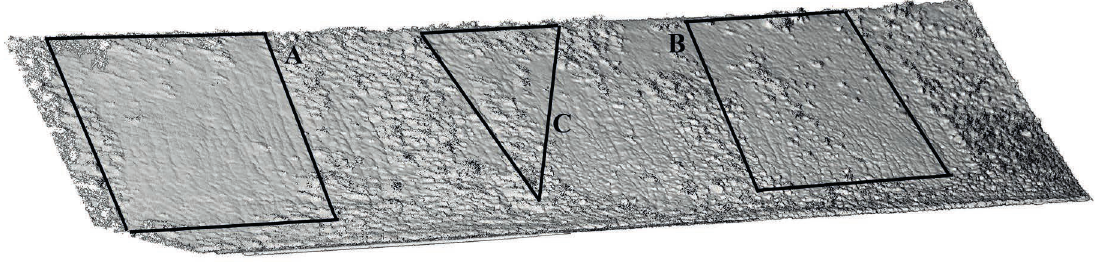
Fig. 3 Fragments of the experimental plot selected for further analysis: A and B – 2013; C –